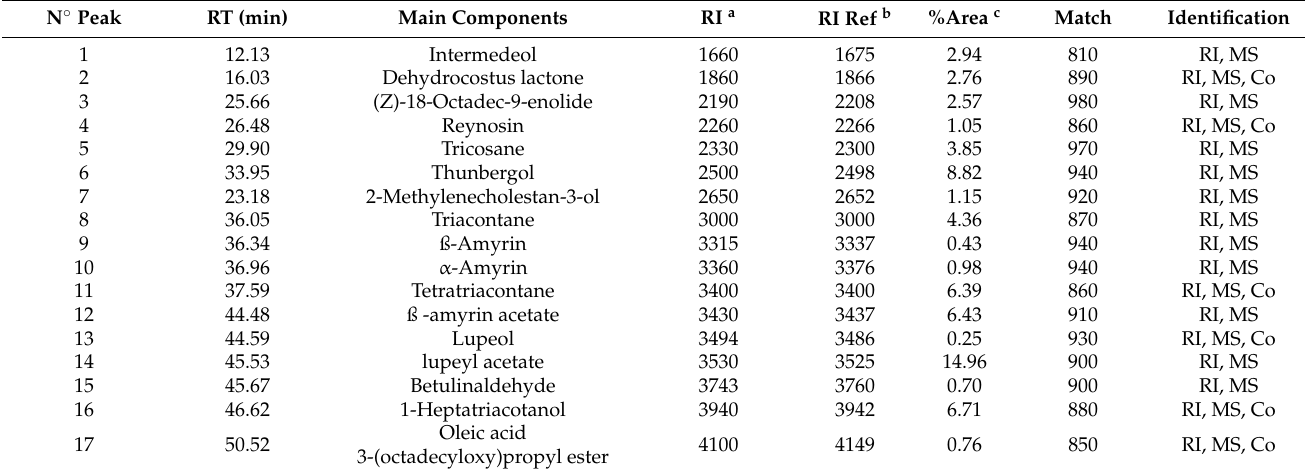
Table 2. Majority composition of DCM extract of L. rivularis